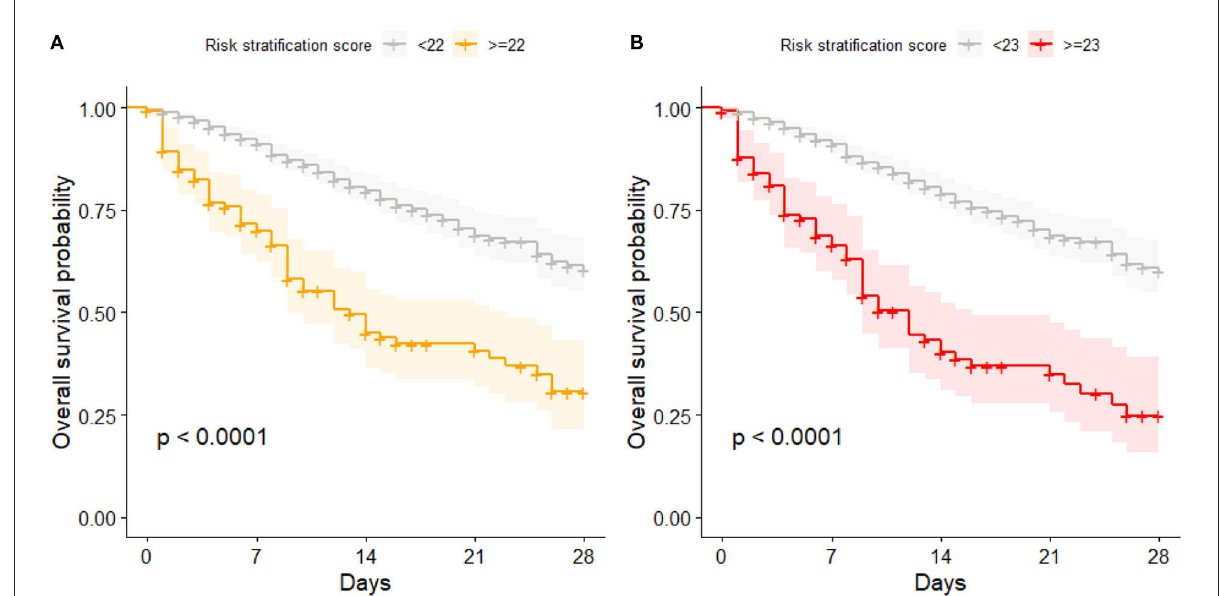
FIGURE1 Kaplan Meier curves for patients with high and low risk of mortality; (A) categorization based on the proposed cutoff of 22 points; (B) categorization based on the cutoff optimized for this data set (23 points).